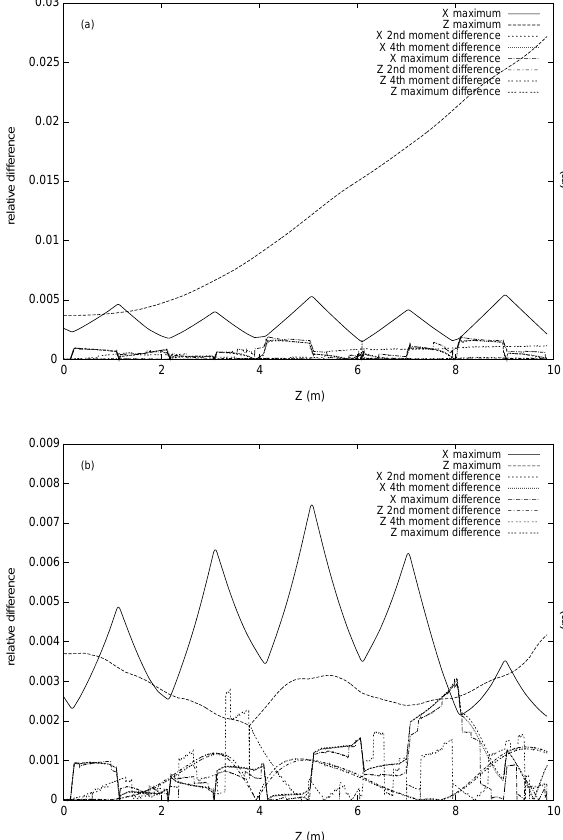
FIG. 7. The relative difference and maximum particle ampli- tude as a function of position for (a) weaker longitudinal focus- ing, and (b) stronger longitudinal focusing than the reference